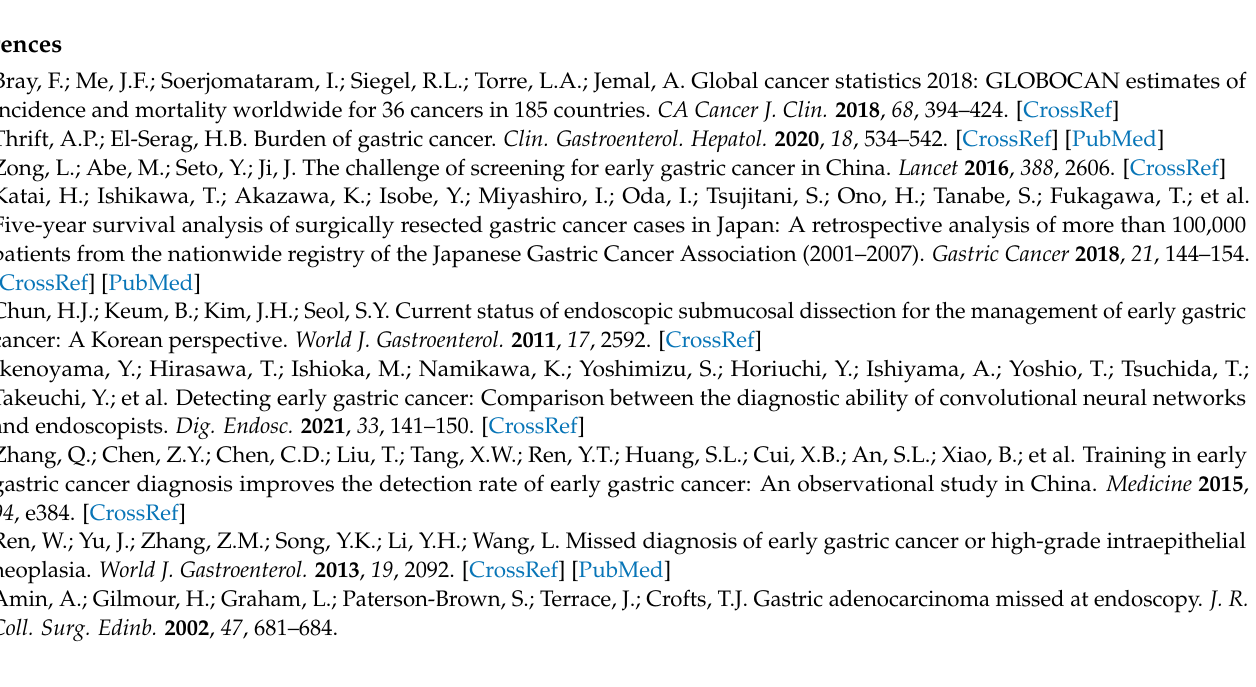
Table S2: Quality Assessment of Diagnostic Accuracy Studies-2 for Included